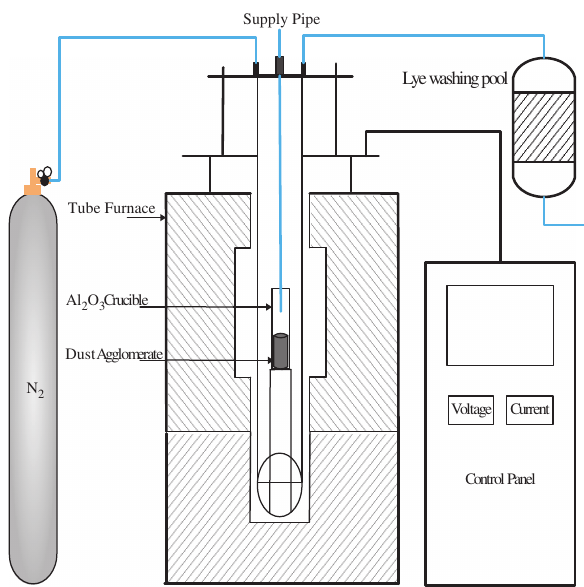
Figure 1: Stainless steel dust briquette reduction scheme diagram.